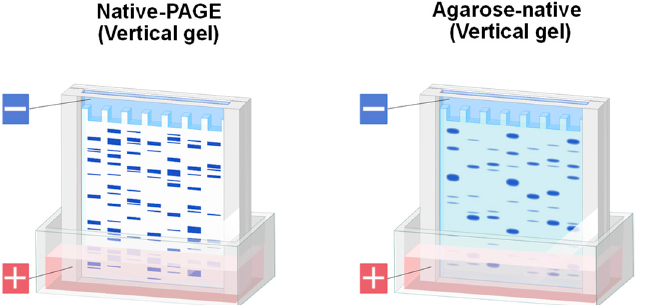
Figure 2. Schematic illustration of vertical gel. Left panel, commercially available native-PAGE. Right panel, agarose gels in vertical mode were prepared using commercially available empty cassette (product details, see [17]).